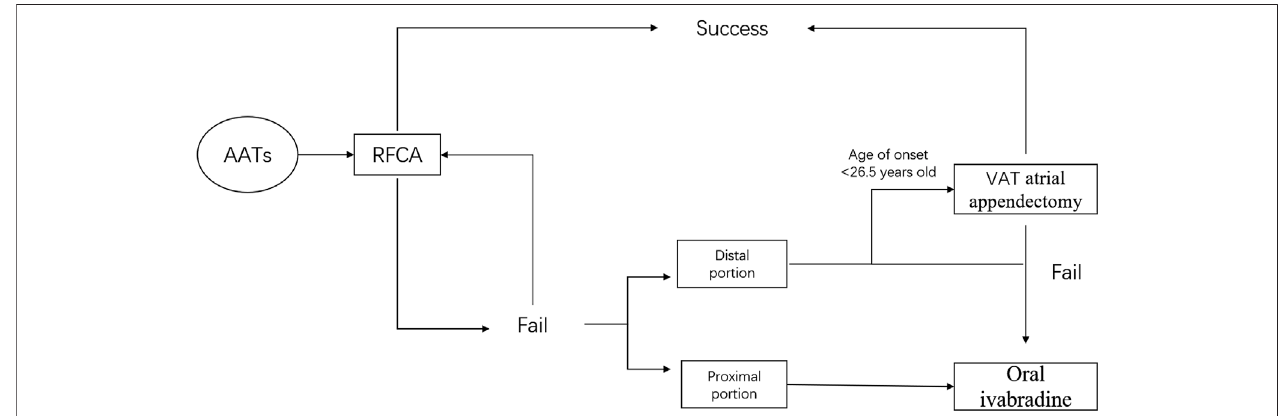
FIGURE 5 | A fl ow chart outlining strategy for the management of AAT. AAT = atrial appendage tachycardia; RFCA = radiofrequency catheter ablation; AA = atrial appendage; VAT atrial appendectomy = video-assisted atrial appendectomy.